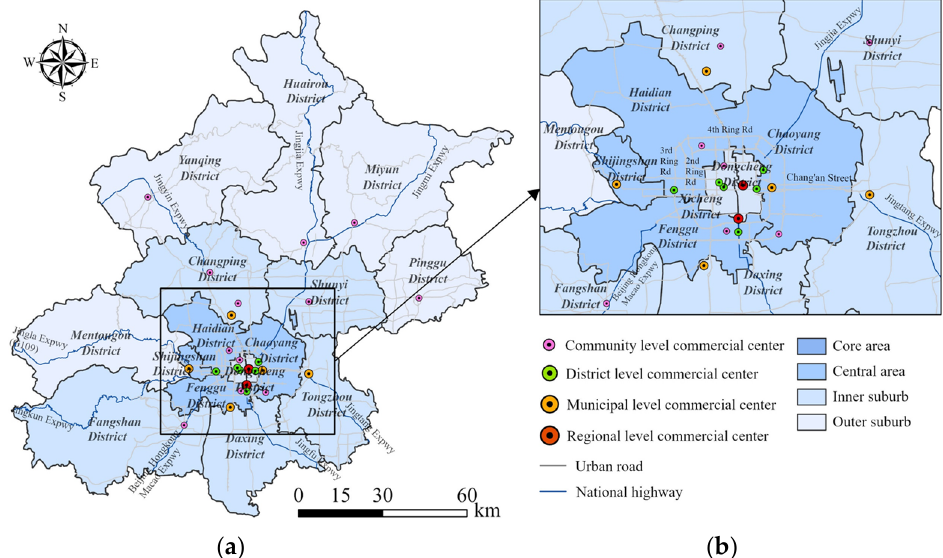
Figure 1. The study area of Beijing: ( a ) the 16 administrative districts and 4 overall planning zones in Beijing, and ( b ) the core and central area of Beijing, with different grades of commercial centers.